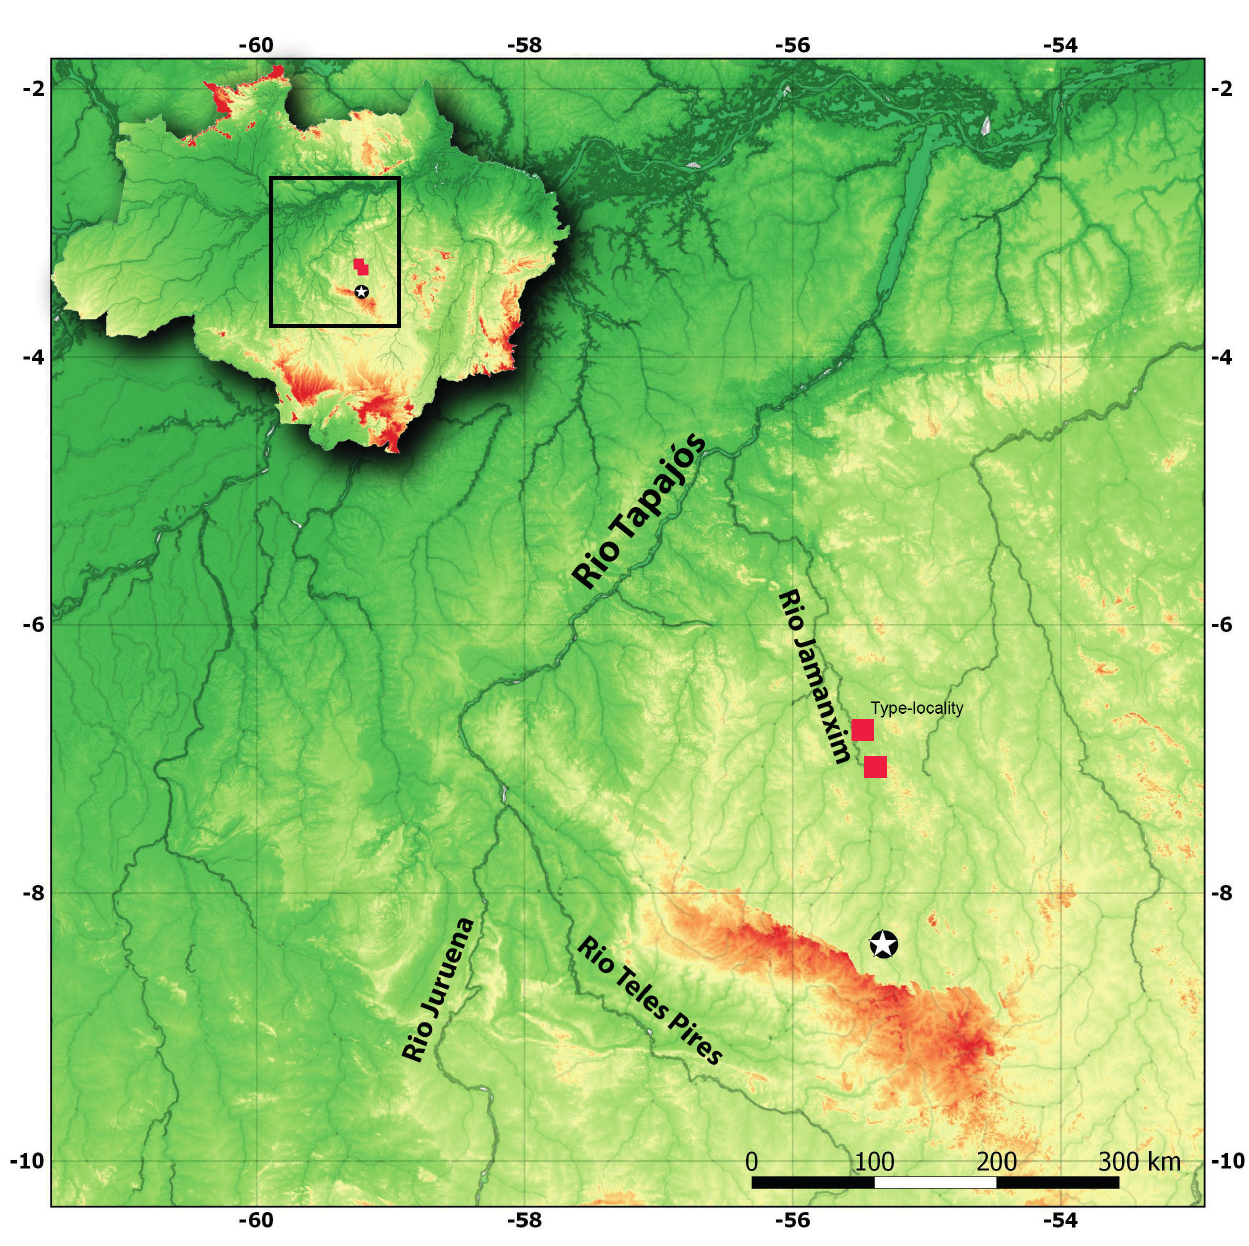
FIGURE 5 | Map of the rio Tapajós and adjoining areas, showing the geographical distribution of Corydoras thanatos (black circle), C. hypnos (white star), and C. psamathos (red squares). Each symbol may represent more than one